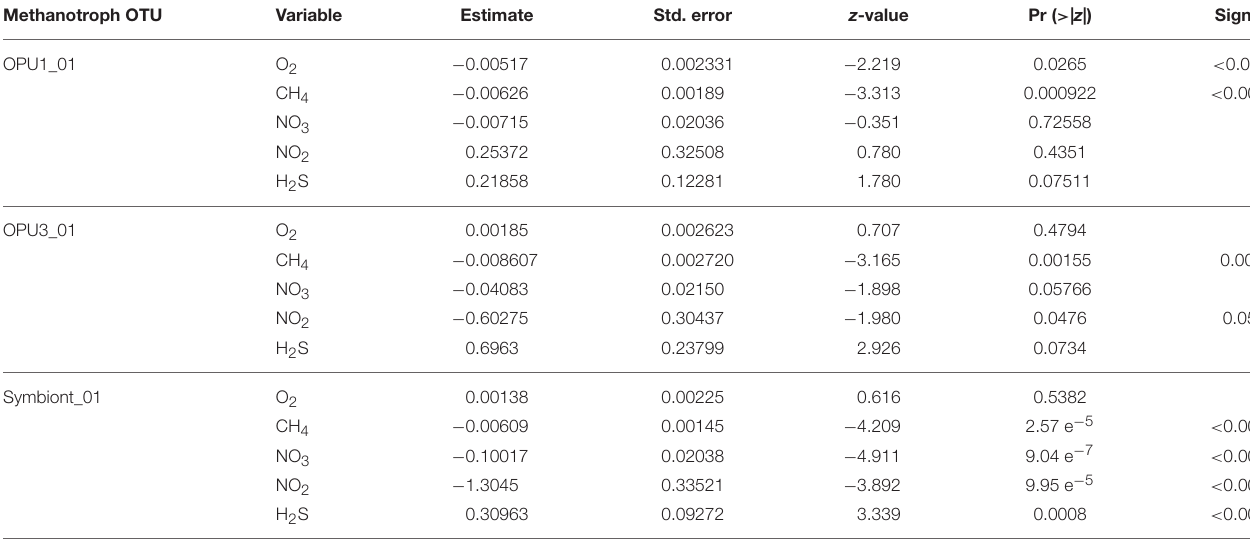
TABLE 2 | Negative binomial regression statistics for methanotroph OTUs. Methanotroph OTU Variable